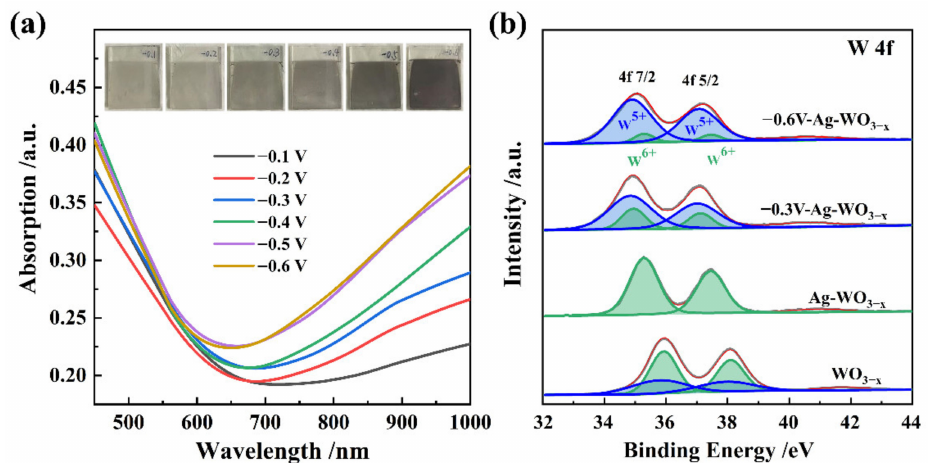
Figure 2. ( a ) Absorption difference spectra resulting from subtraction of the background absorbance from the absorption spectra of Ag-WO 3 − x film acquired at different activated potentials. Inset shows the corresponding photographs of Ag-WO 3 − x film. ( b ) XPS profiles of WO 3 − x and Ag-WO 3 − x at activation potentials of 0, − 0.3, and − 0.6